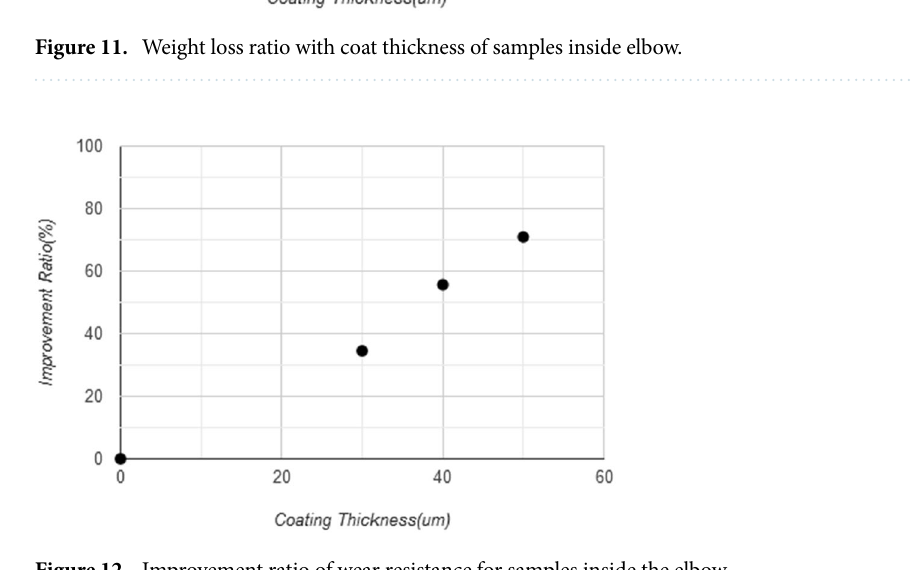
Figure 12. Improvement ratio of wear resistance for samples inside the